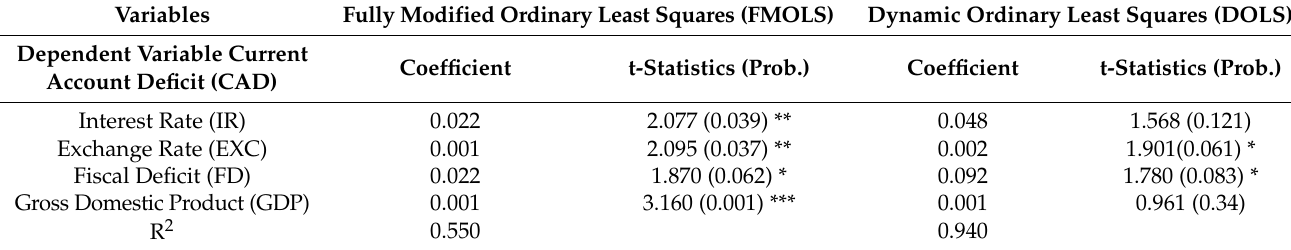
Table 6. Results of FMOLS and